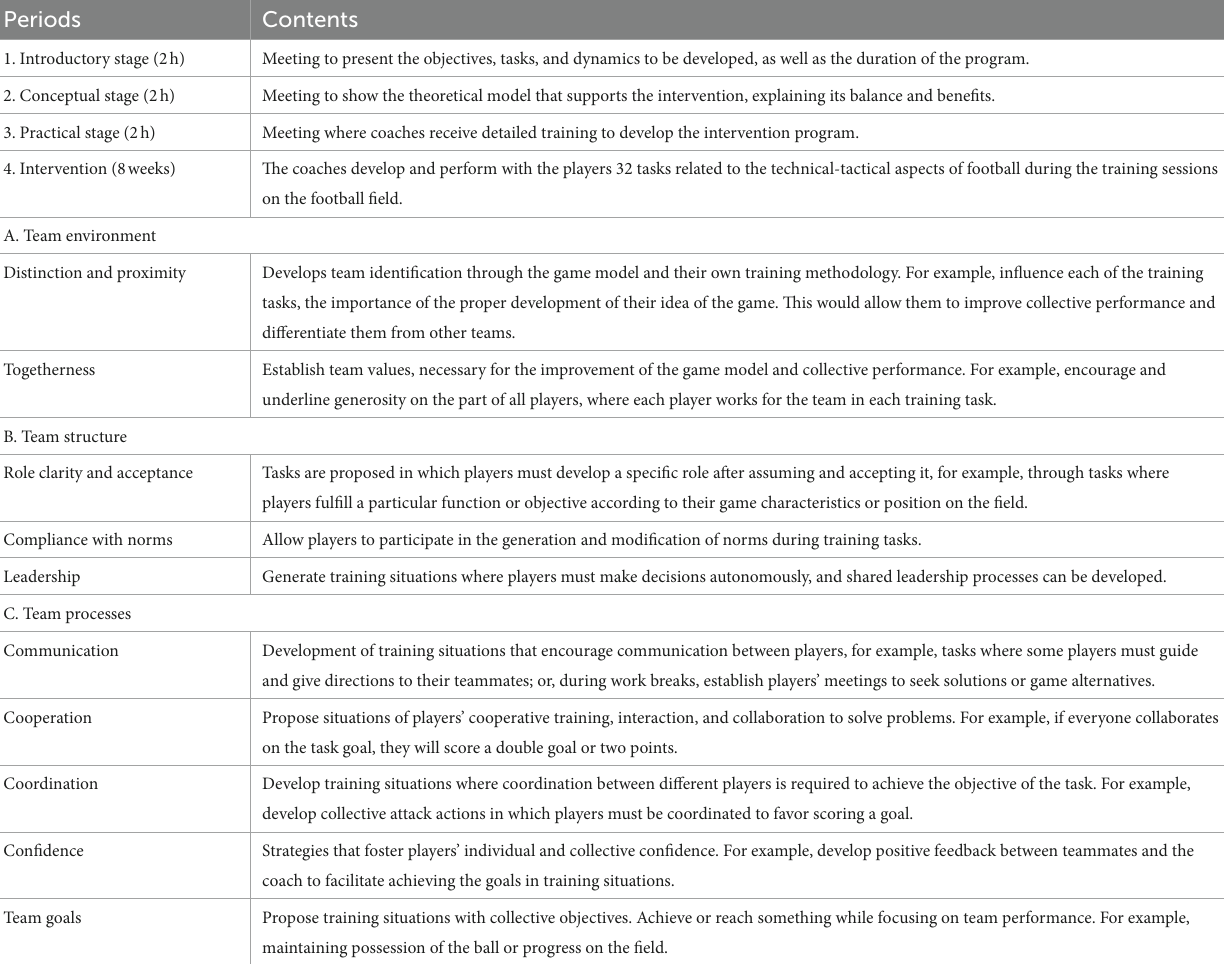
TABLE 1 Intervention program based on team